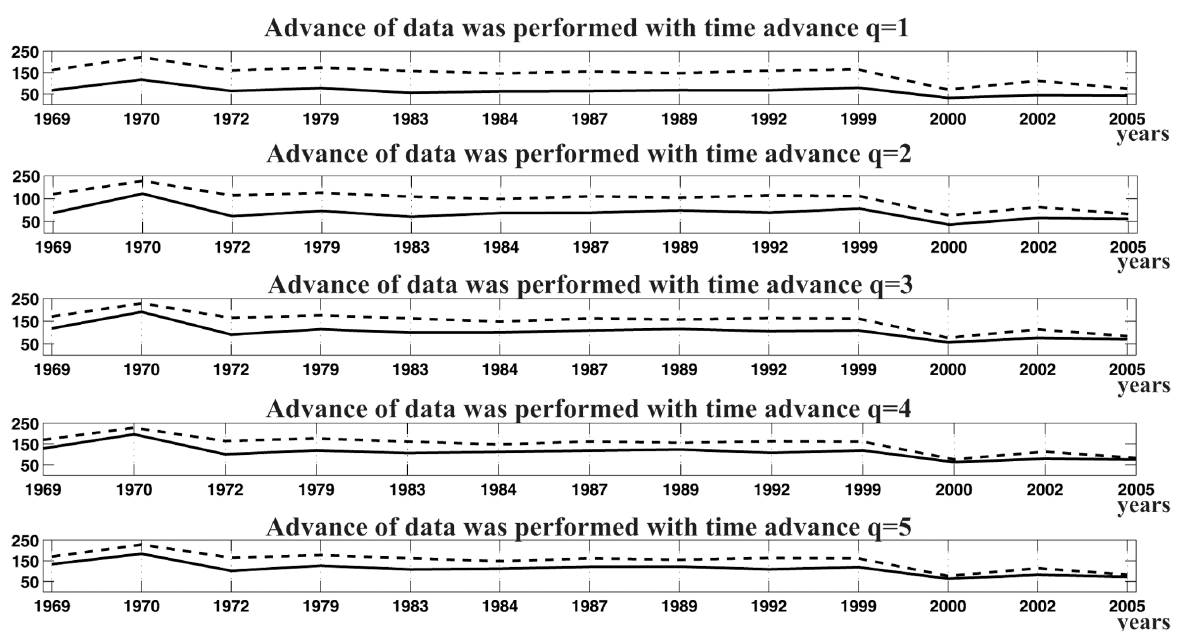
e 2 , e is ARIMA model errors, K is the number of k k k =1